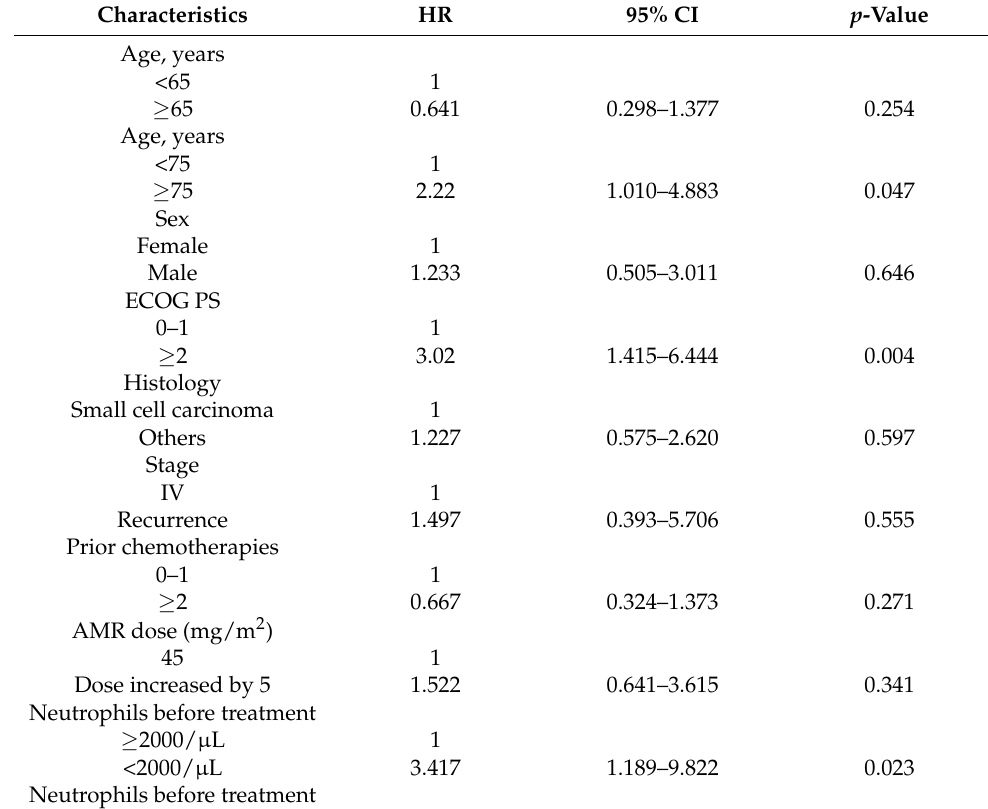
Table 5. Potential risk factors for FN by the univariate Cox proportional hazards analysis ( N = 156).